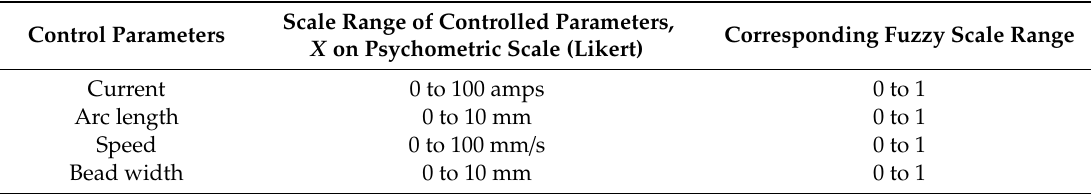
Table 1. Psychometric and fuzzy scaling for the parameters.